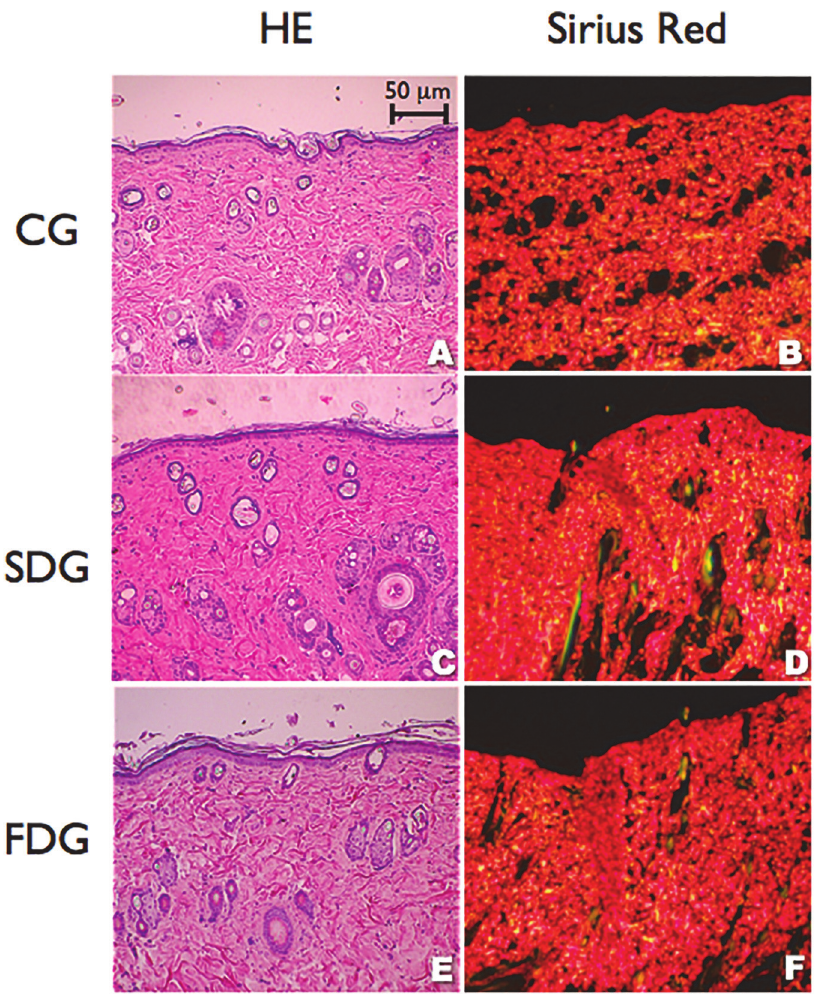
Fig 7. Morphology of wound healing on Day 22, showing similarity among experimental groups (hematoxilyn and eosin — A, C, E; Picrosirius Red — B D, F)